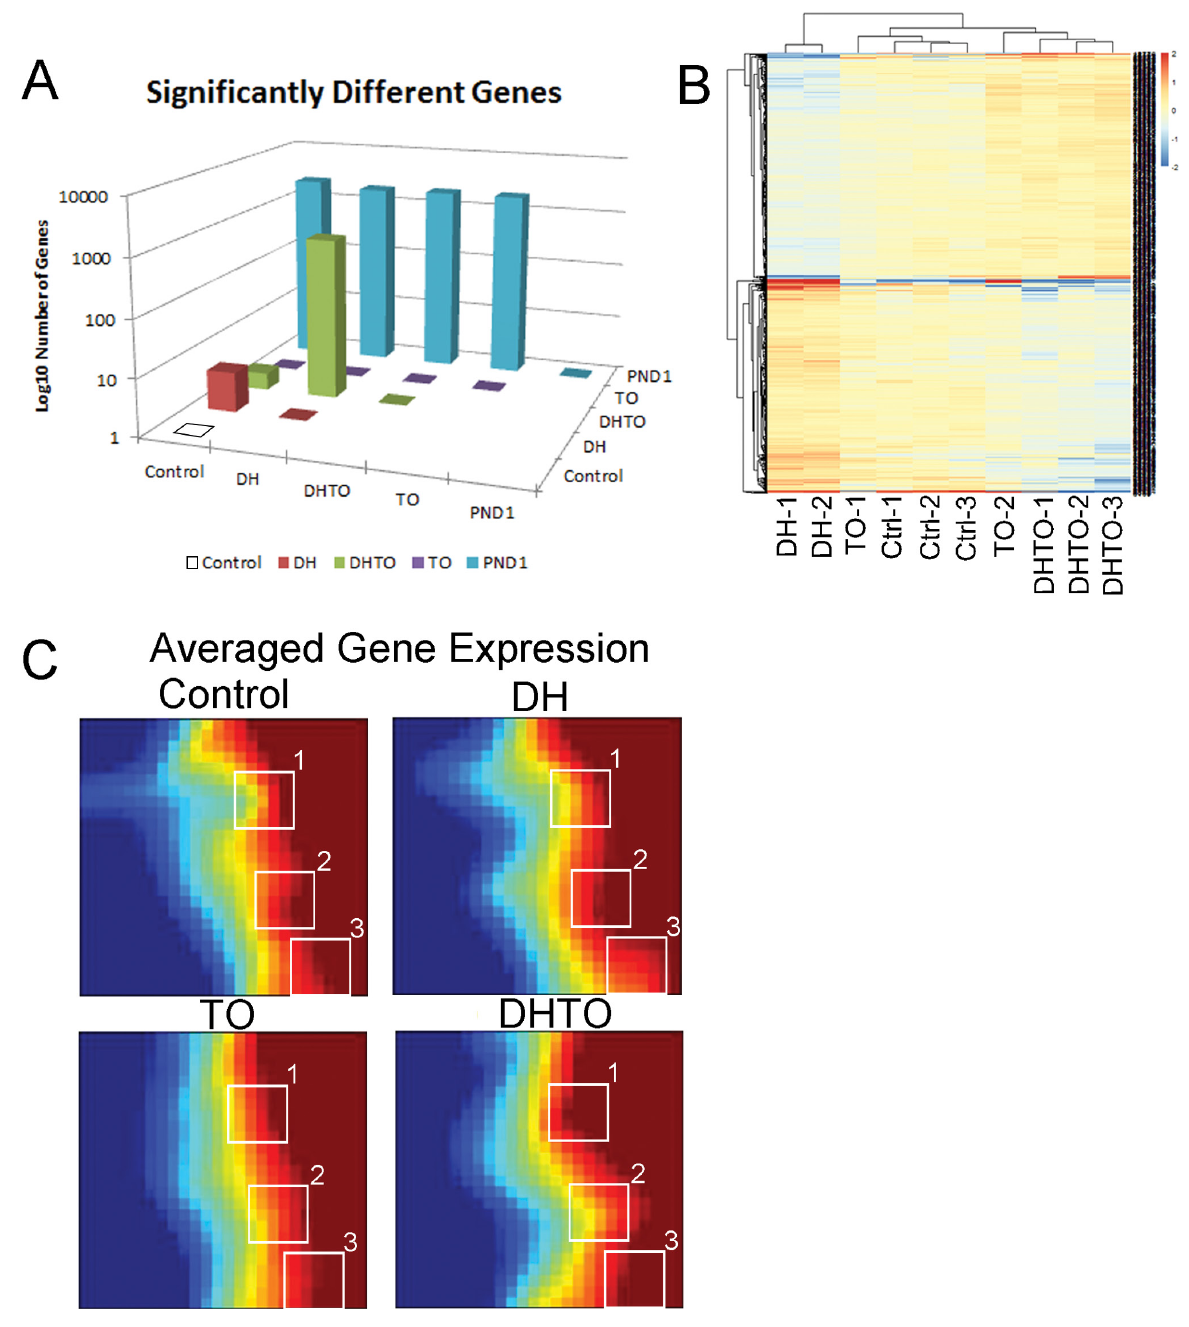
Figure 4. TO reverses and overcompensates for many of the gene expression changes induced by surgical DH. (A) After false discovery correction and using a p < 0.1 level of significance and comparing each group to the others, there were very few genes with signifi- cantly different levels of expression among the 13,687 genes analyzed. The exception to this was an increased number of differentially expressed genes between DH and DHTO (687 genes). As expected, PND1 rabbit lung had more differentially expressed genes than fetal lung time points. Note the log10 scale. (B) Hieratical clustering of gene expression profiles demonstrated that TO was more similar to control than DHTO and that DHTO was more like control (Ctrl) than DH. (C) Gene Expression Dynamics Inspector (GEDI) was used to generate average gene expression heat maps for each fetal lung group. DHTO had higher expression of the genes grouped in region 1 and lower levels of gene expression in region 2 compared with control, DH and TO. In region 3, DH had reduce levels of gene expression compared with control and DHTO had higher expression levels of these